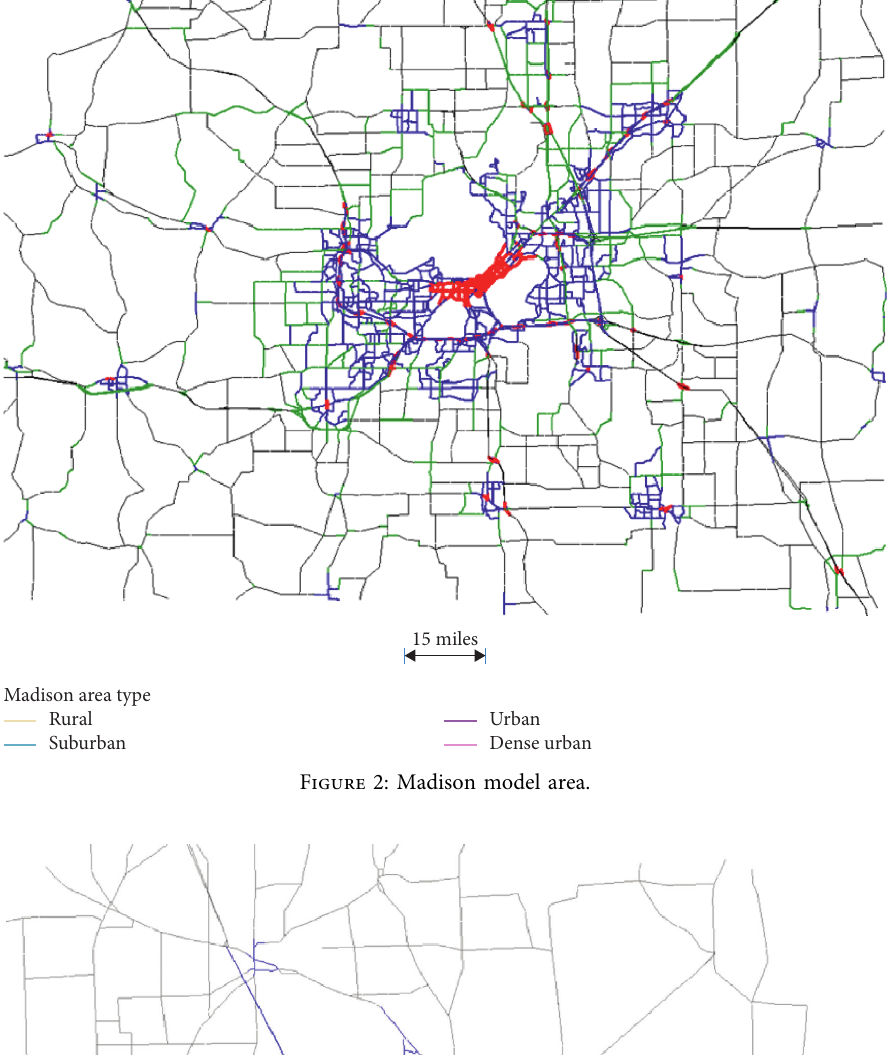
Figure 2: Madison model area.